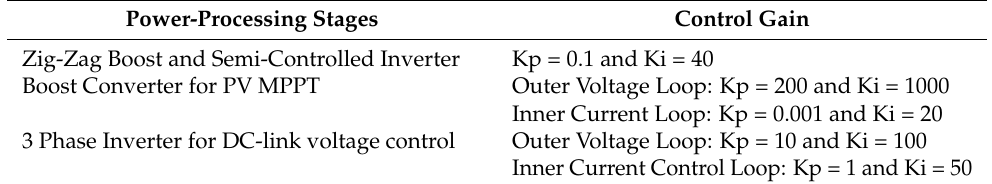
Table 2. Control gain parameters for the different power-processing stages of the proposed